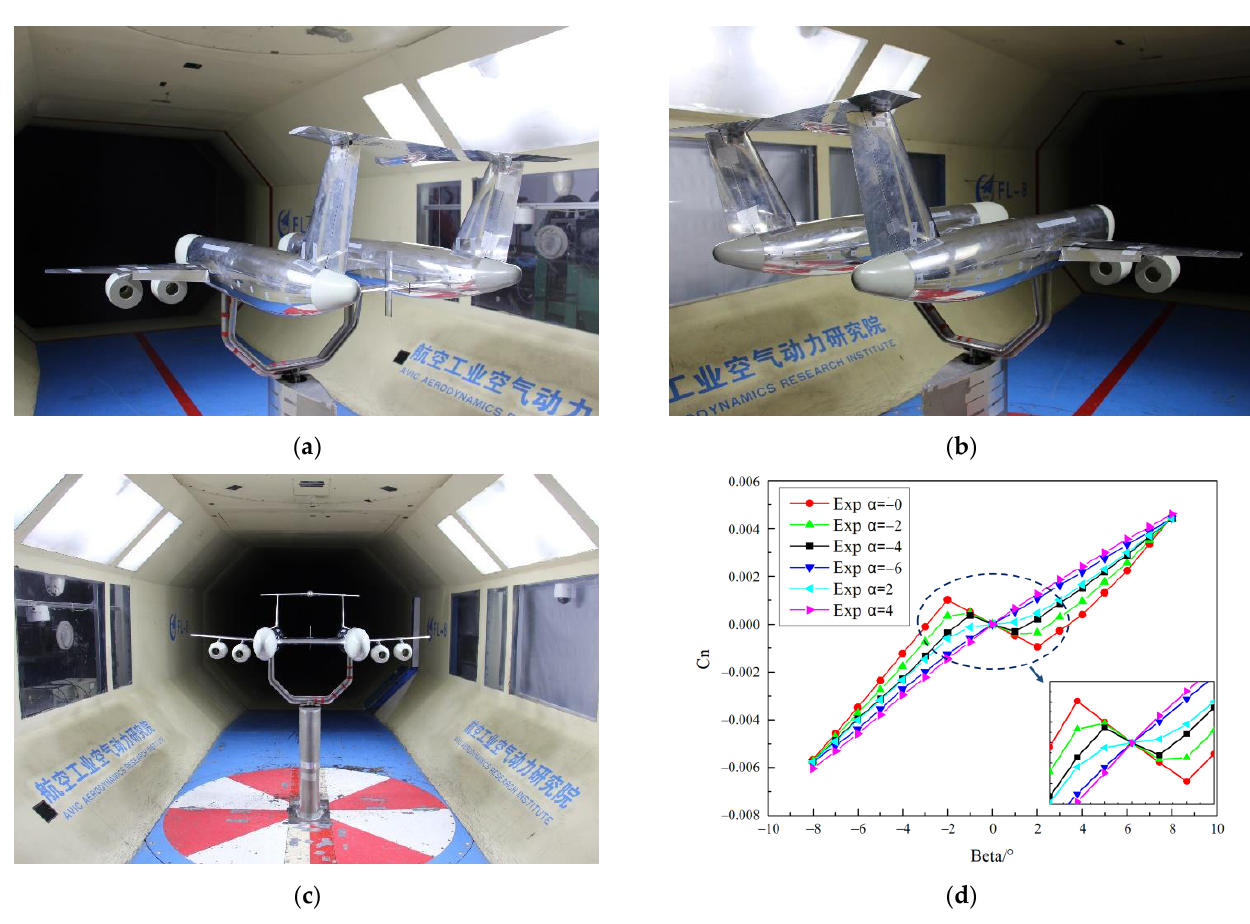
Figure 8. Experimental model of the demonstration aircraft in a wind tunnel: ( a ) left side of the aircraft; ( b ) right side of the aircraft; ( c ) front of the aircraft; ( d ) results for coefficient of yaw moment.